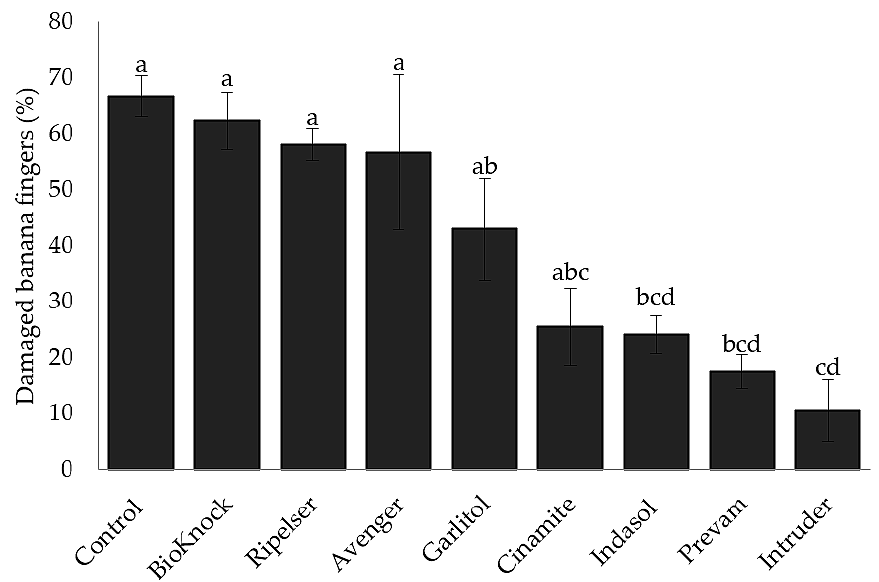
Figure 4. Percentage of damaged banana fingers per treatment. Different letters above bars indicate a significant difference among the groups according to ANOVA followed by Tukey’s HSD test ( p < 0.05).